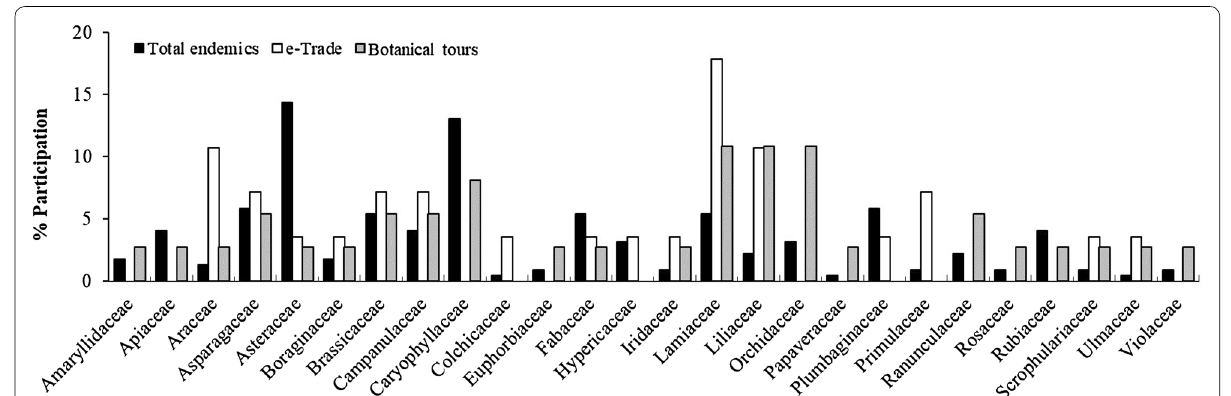
Fig. 1 Frequency of occurrence (%) of plant families represented in the e-trade of the endemic plants of Crete, Greece (marked with white) and in wildlife tourism (marked with grey) and relative participation of these families in the endemic flora of Crete (marked with